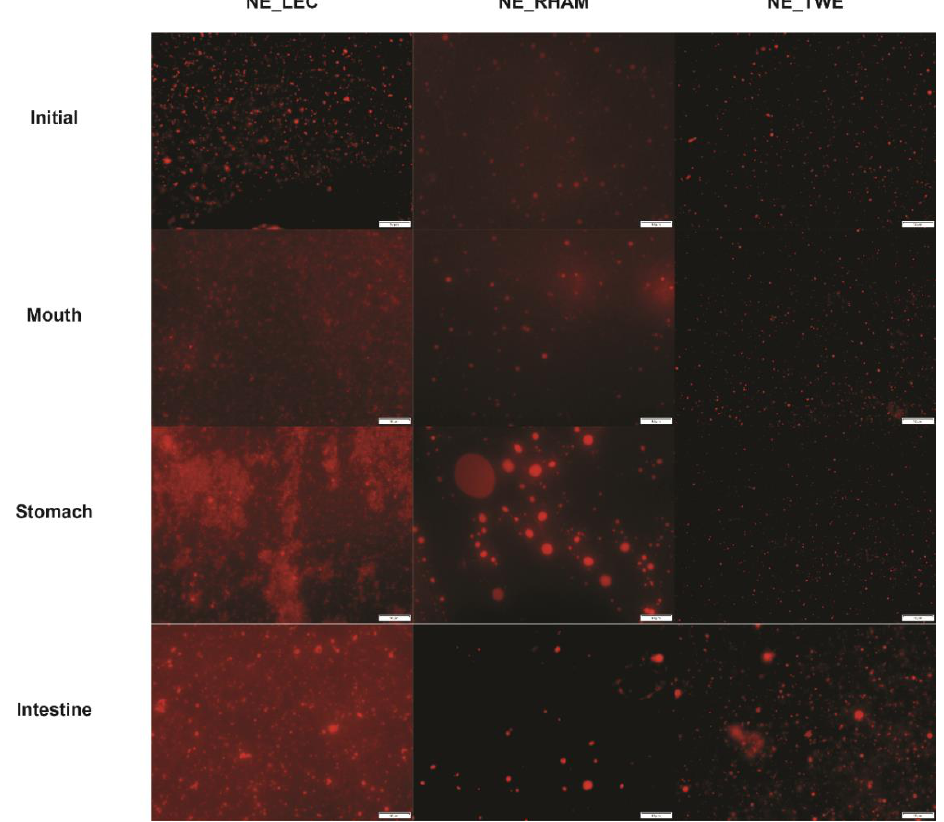
Figure 3. Fluorescence microscopy images of nanoemulsions (NEs) with different emulsifiers (lecithin (LEC), rhamnolipids (RHAMs), and Tween ® 80 (TWE)) after each in vitro gastrointestinal digestion phase. The scale bar for all images is 10 µ